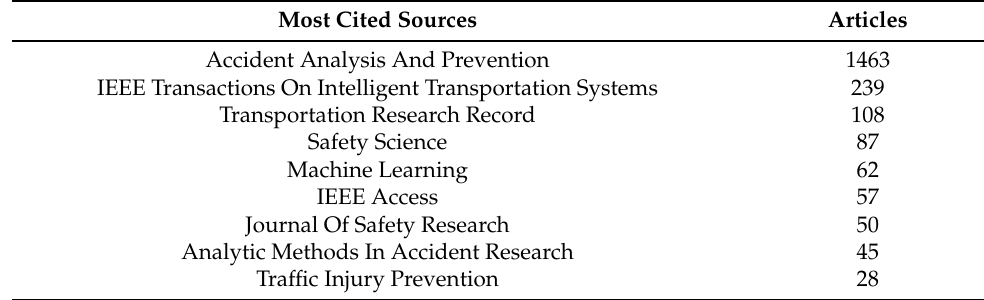
Table 2. Most cited journals in the fields of road accidents, crash severity, and AutoML.